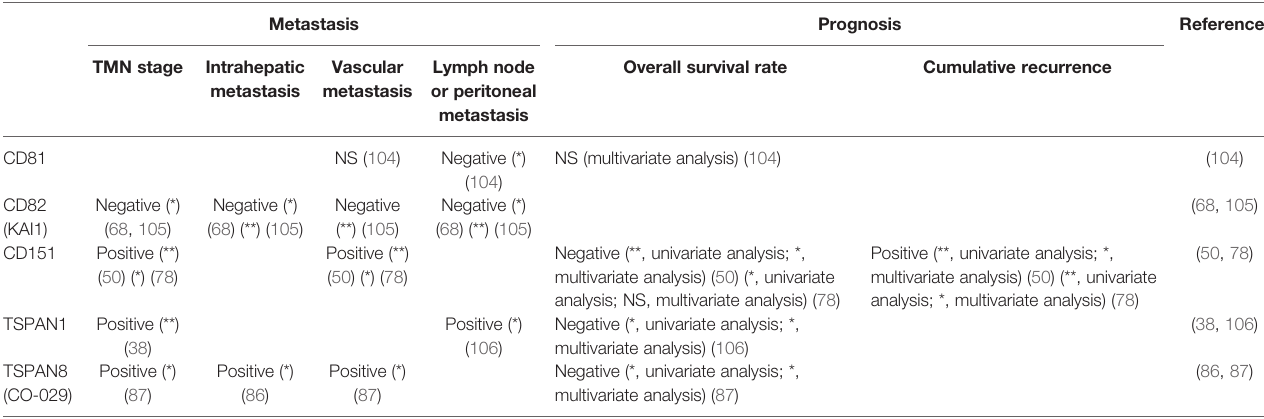
TABLE 3 | The relationship between the level of tetraspanins and tumor metastasis, patient